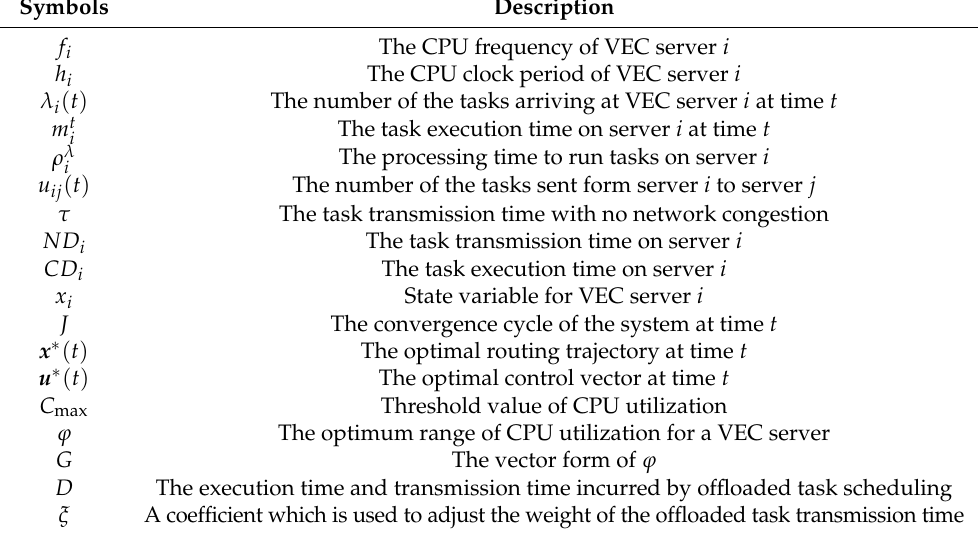
Table 1. Description of the symbols.